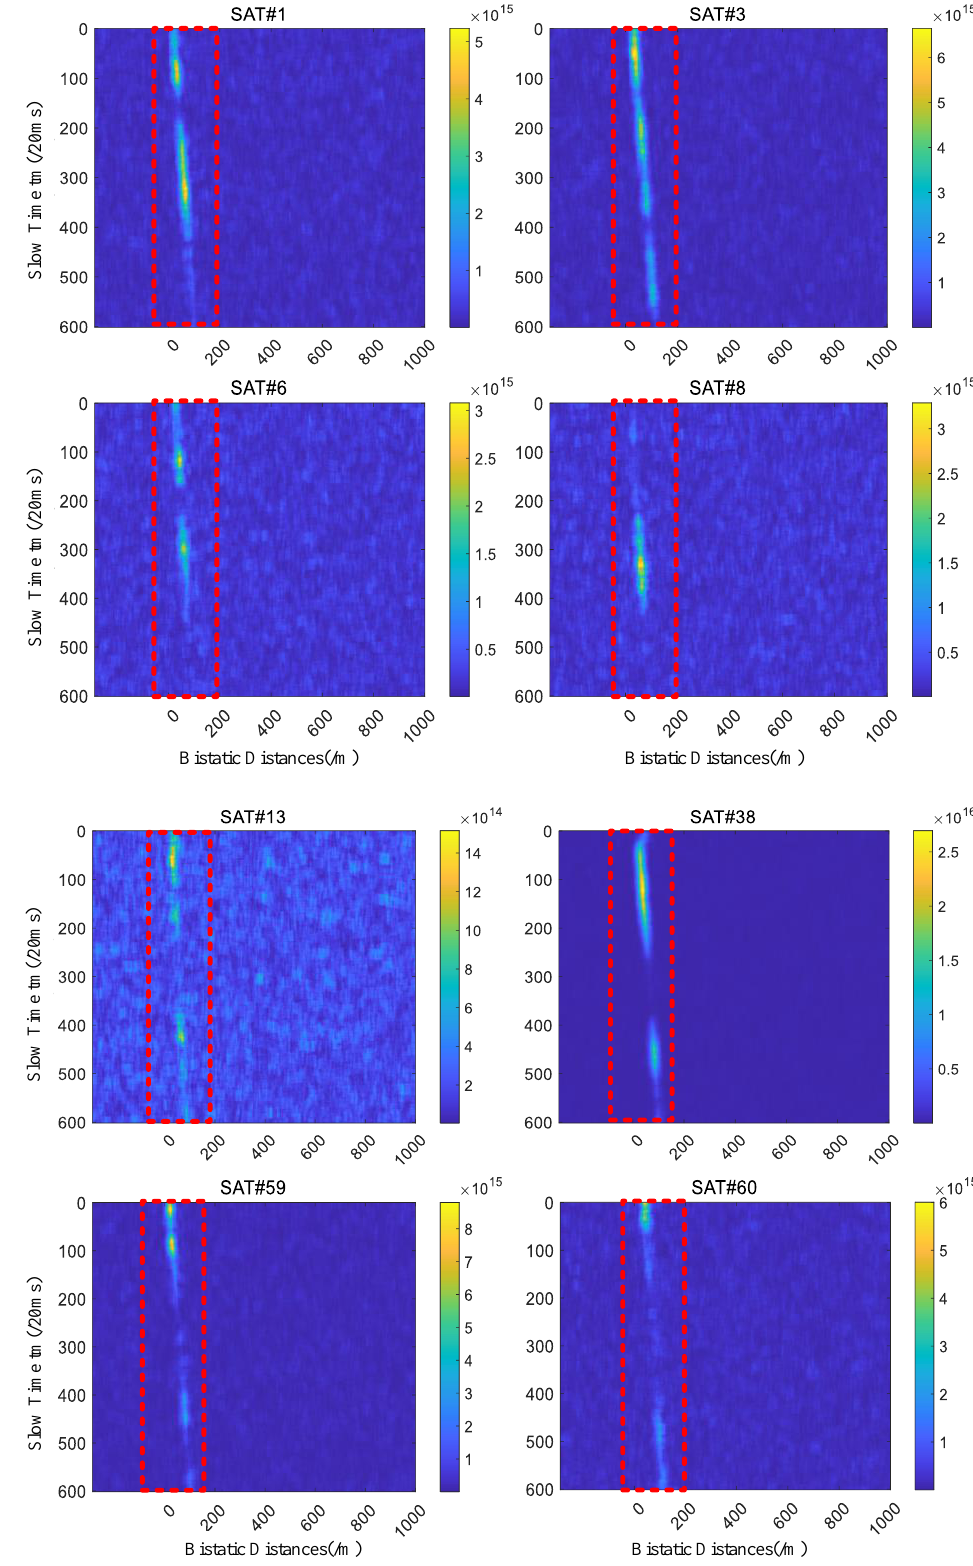
Figure 16. Trajectories of target echoes from 8 satellites.